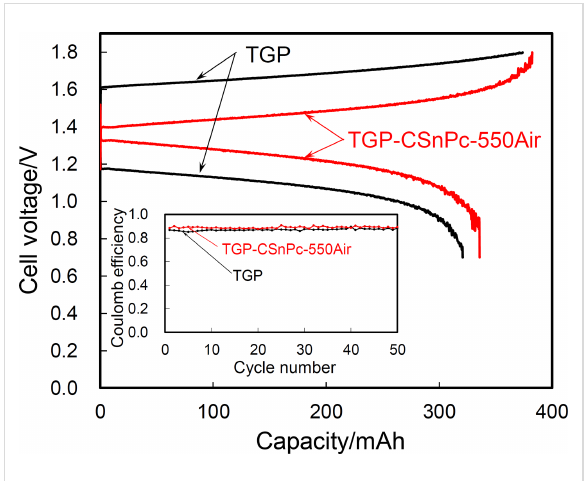
Figure 6: Charge–discharge curves and cycling performance for flow cells using three layers of TGP and TGP-CSnPc-550Air as electrodes. The electrode area was 3 cm 2 . The current density was 50 mA·cm − 2 . The flow rate was 3 cm 3 ·min − 1 . The concentrations of the vanadium species and sulfate ion in the anolyte (20 cm 3 ) and catholyte (20 cm 3 ) were 1 and 3 M,